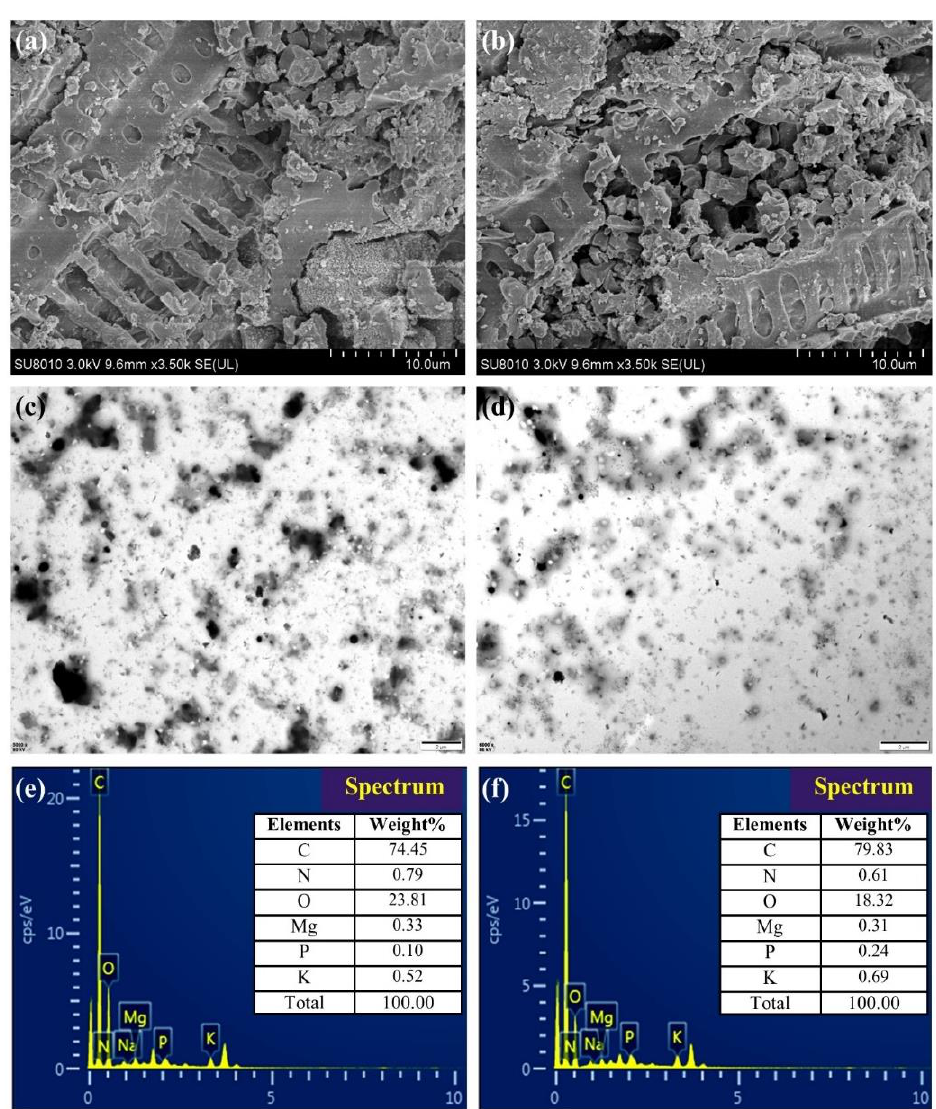
Figure 1. Characterization of corn cob biochar samples pyrolyzed at 300 °C and 400 °C. ( a ) SEM analysis of biochar pyrolyzed at 300 °C, ( b ) SEM analysis of biochar pyrolyzed at 400 °C, ( c ) TEM analysis of biochar pyrolyzed at 300 °C, ( d ) TEM analysis of biochar pyrolyzed at 400 °C, ( e ) EDS analysis of biochar pyrolyzed at 300 °C, ( f ) EDS analysis of biochar pyrolyzed at 400 °C.